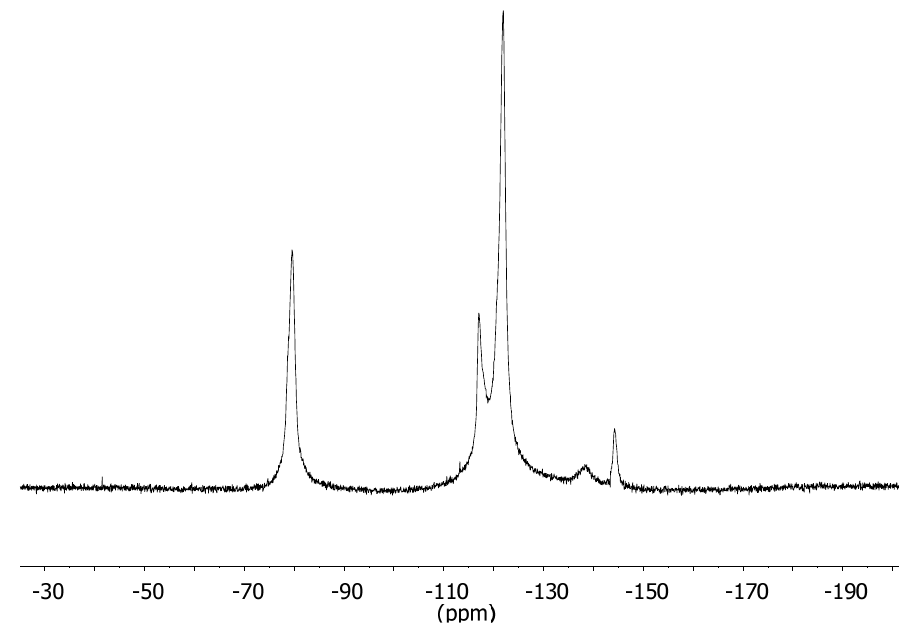
Figure 1. 19 F Nuclear Magnetic Resonance (NMR) spectrum of representative Nafion ionomer in static fluorine-free probe at 25 °C.